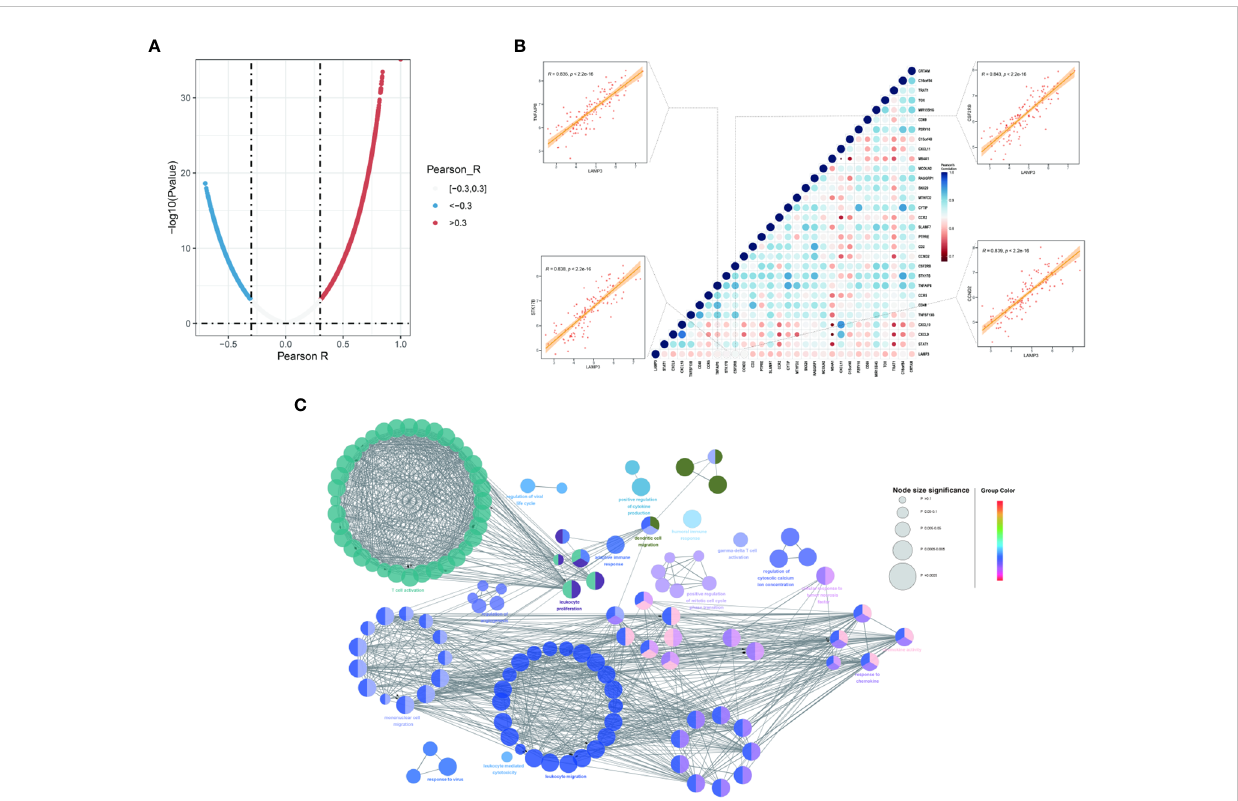
FIGURE 3 Associations between LAMP3 and key genes related to immune cell regulation. (A) The spoon-shaped plot shows genes related to LAMP3 expression calculated by Pearson correlation analysis. (B) Correlation between immunocyte regulatory genes and LAMP3, and their impact on HBV infection. (C) Visualization of the interaction network of genes strongly associated with LMAP3 by Cytoscape (ClueGO module). Node size, p value; Node color, gene groups. HBV, Hepatitis B virus; LAMP3, lysosome-associated membrane glycoprotein